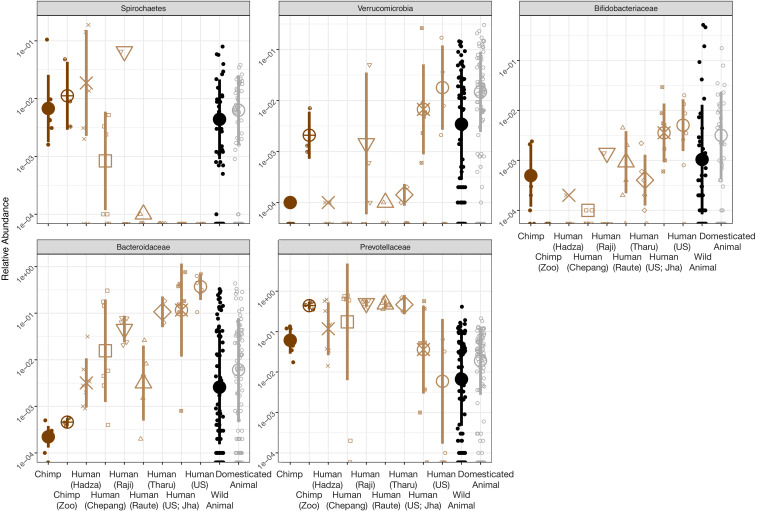
Trends in gut microbial taxa previously linked to differing human lifestyles.Abundance of gut microbial taxa previously identified as distinguishing among human lifestyles (Smits et al., 2017) trended in similar directions between domesticated and wild animals as between industrialized humans and wild chimpanzees, except for the bacterial families Prevotellaceae and Spirochaetes. Human populations represented include the Hadza (Tanzanian hunter-gatherers), Chepang (Nepalese foragers), Raji (Nepalese foragers transitioning to subsistence farming), Raute (Nepalese foragers transitioning to subsistence farming), Tharu (Nepalese subsistence farmers), and Americans drawn from Jha et al., 2018 as well as Americans sampled and sequenced by our team. Large shapes are means; bars show standard deviations.